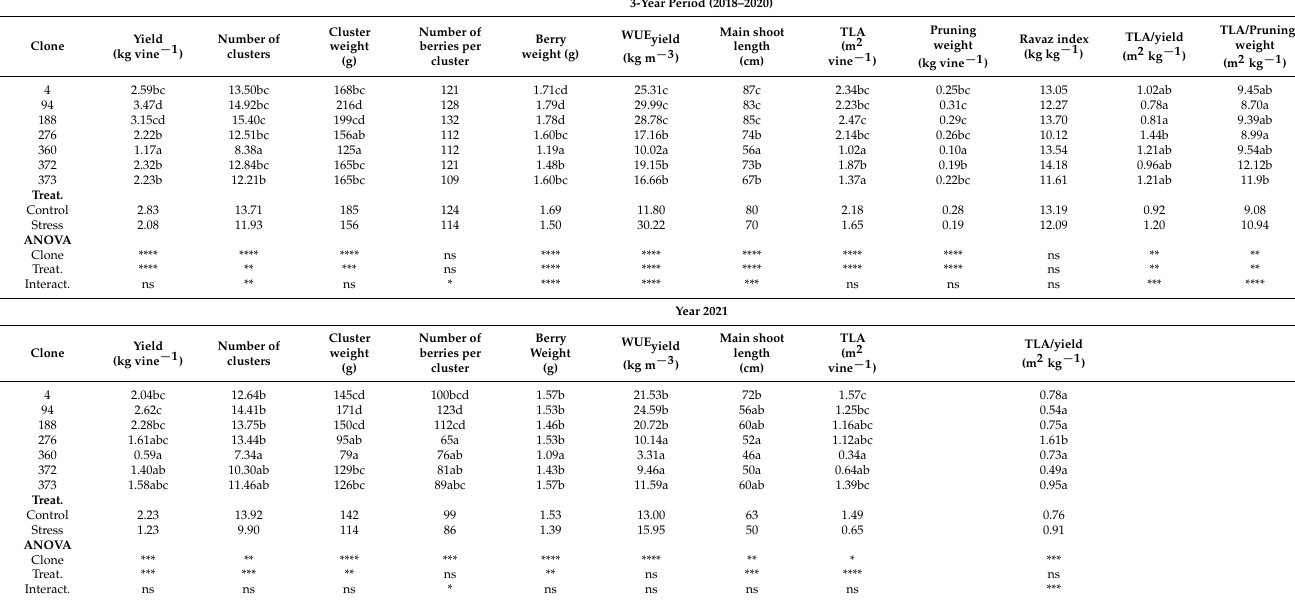
Table 5. Average annual values of yield components at harvest for each clone, irrigation treat- ment, and the interaction (clone × irrigation treatment) during the experimental period (2018–2021): WUE yield (productive water use efficiency, kg m − 3 ). Average values of vegetative development parameters (main shoot length, total leaf area –TLA- and pruning weight) for each clone, irriga- tion treatment, and the interaction (clone × irrigation treatment) during the experimental period